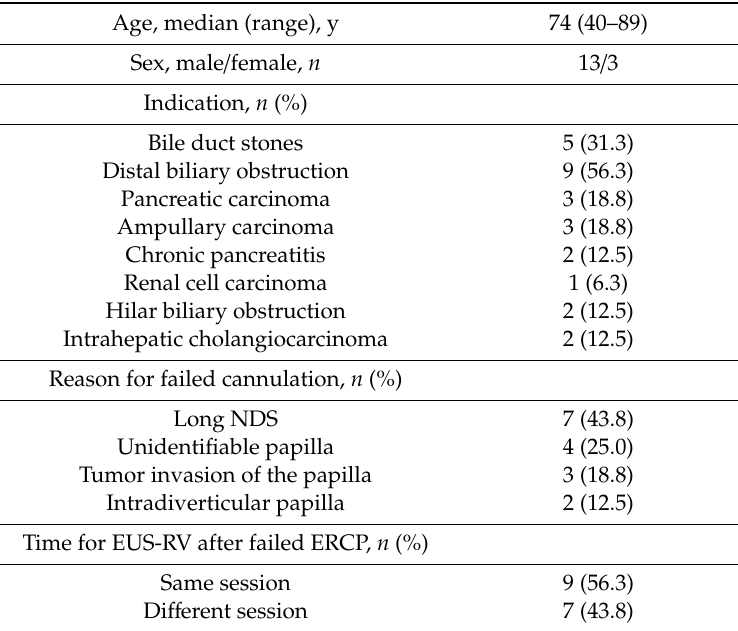
Table 2. Baseline